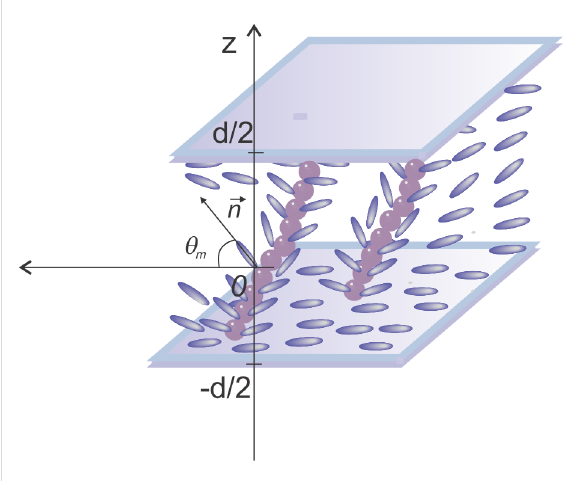
Figure 2: The deviation angle of molecular director inside a planar cell.